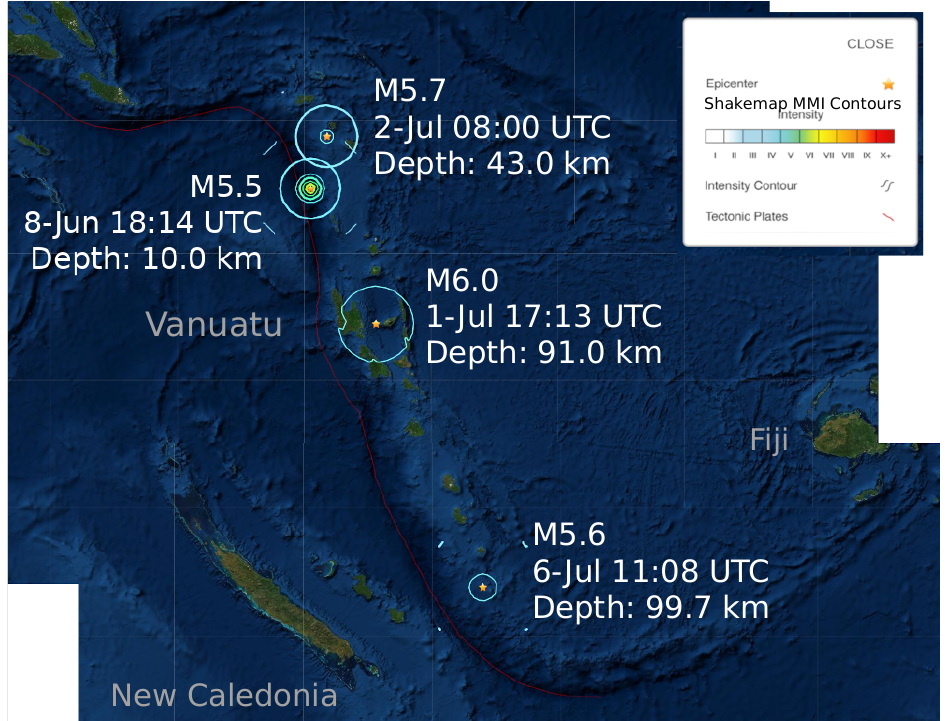
Figure 10. Some of the larger earthquakes around Vanuatu at the beginning of July 2017, showing their epicenters, time, depth and surface felt magnitude shakemaps. It can also be seen the submarine trench and the tectonic fault between Australian and Pacific